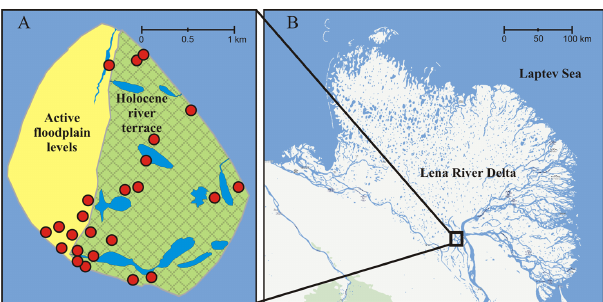
Fig. 1. (A) Map of Samoylov Island with locations of study sites. (B) The investigation area in the Lena River Delta in northeast Siberia with the location of Samoylov Island (Map B based on Google and Geocentre Consulting